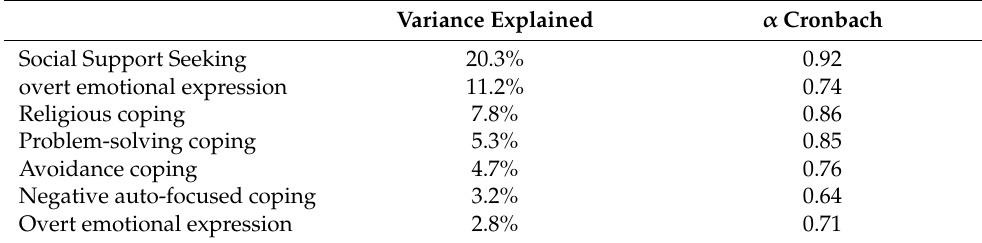
Table 2. Correlations between factors and Cronbach’s alpha